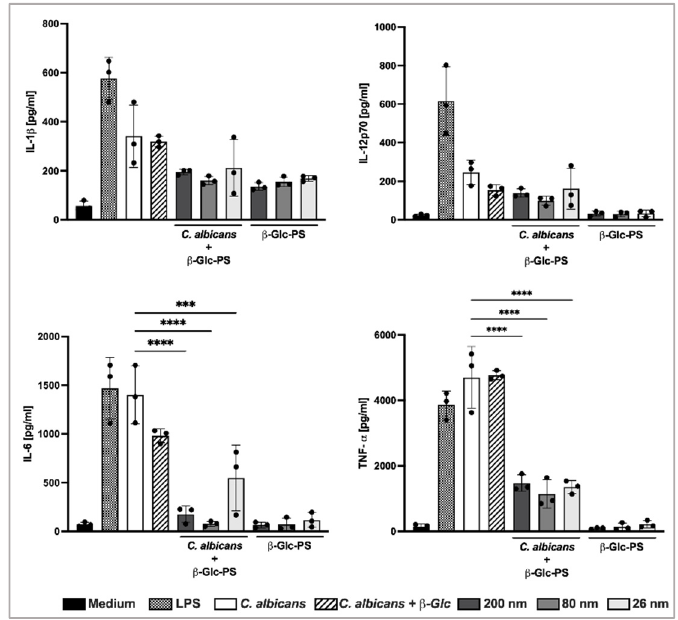
Figure 6. Quantification of cytokines in supernatants of BMDC cultures. The levels of TNF- α , IL-1 β , IL-6 and IL-12p70 secreted by BALB/c mice BMDC were quantified by sandwich ELISA. Immune cells were incubated with live C. albicans SC5314 at a MOI of 1:5 (1 DC: 5 yeast cells) for 24 h. The 80 nm β -Glc-PS (10 μ g/mL) were added 1 h prior to infection. Each condition was set in triplicate. Each black dot corresponds to the mean value of the three technical replicates of an independent experiment. Bars correspond to means ± one SD. One-way ANOVA with Tukey’s post hoc test. (*** p < 0.001; **** p < 0.0001). The complete statistical analysis data is presented in the Supplementary material (Table S3).